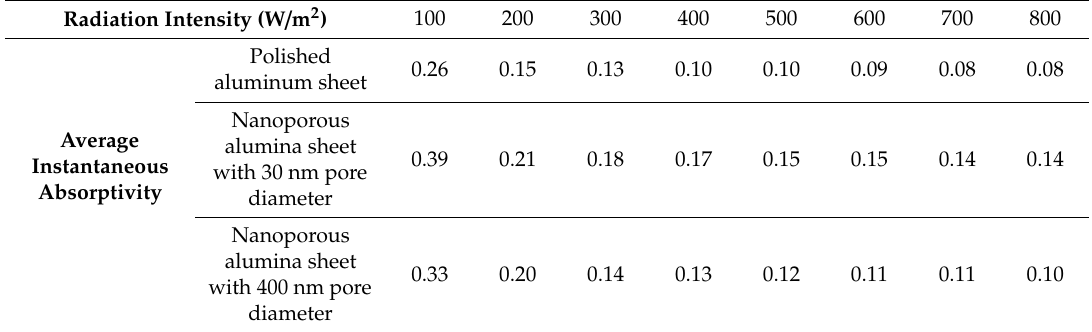
Table 2. Average instantaneous absorptivity for the testing rigs operated under di ff erent radiations. Radiation Intensity (W / m 2 )